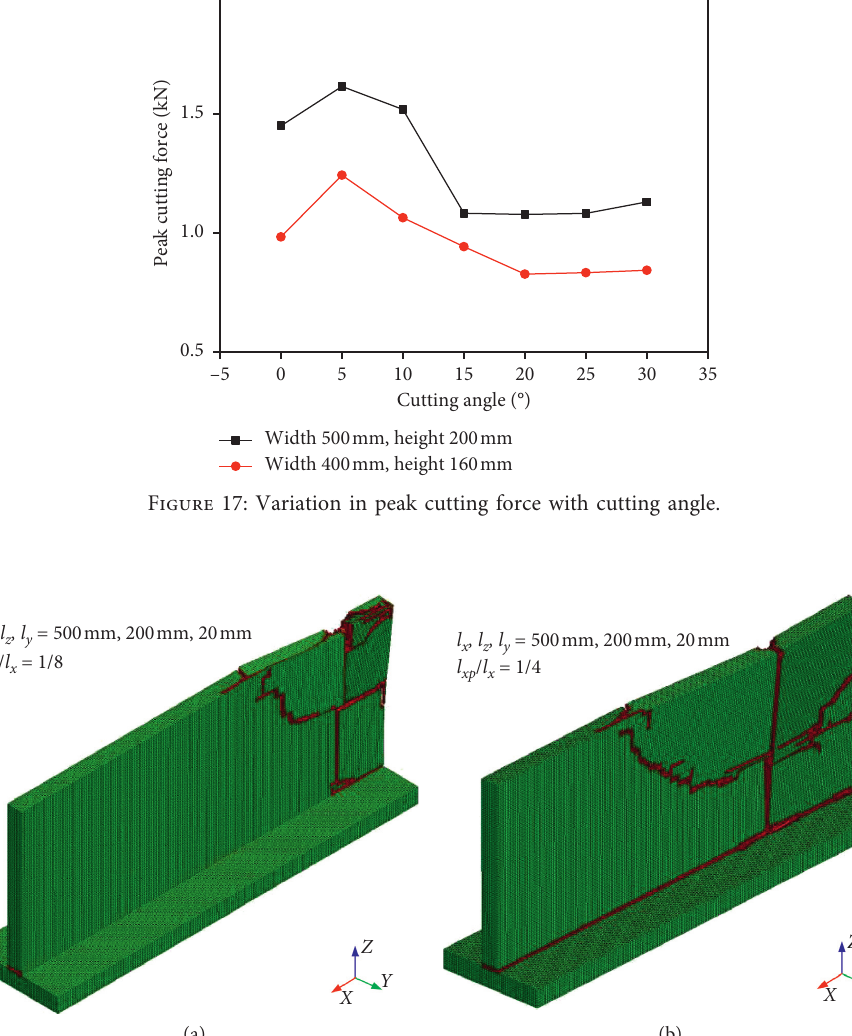
� 1/8 and (b) l � 1/4. xp / l x xp / l x